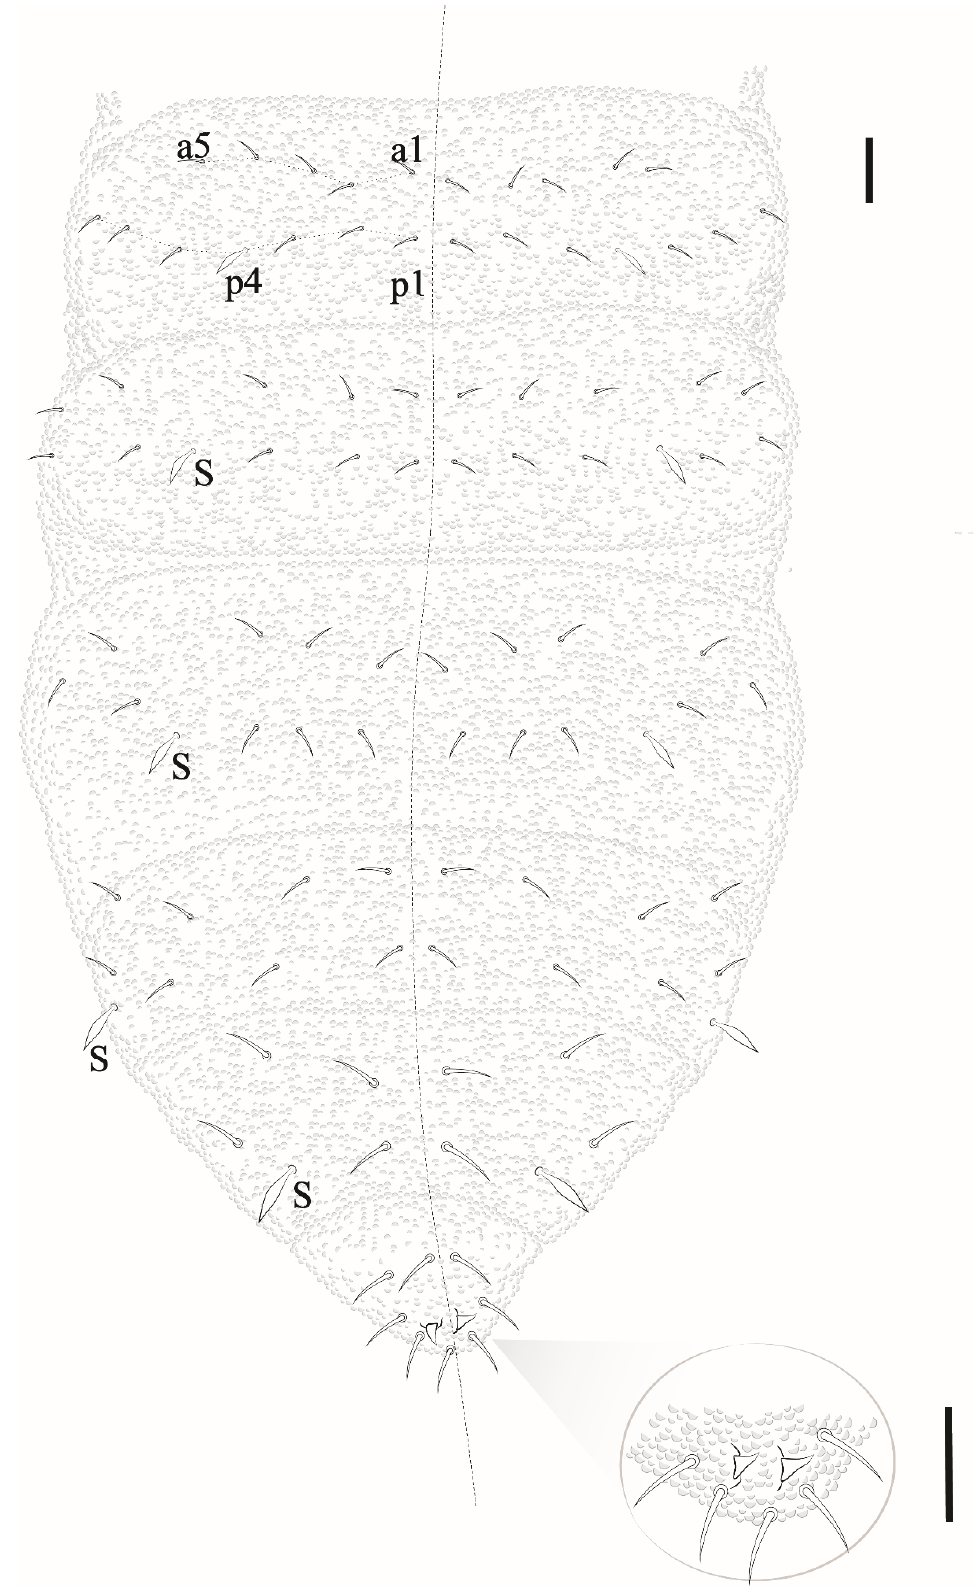
Figure 22. Willemia insularum sp. nov., dorsal view of Abd I–VI, anal spine details. Scale bars: 10 µm and anal spine detail, 20 µm.